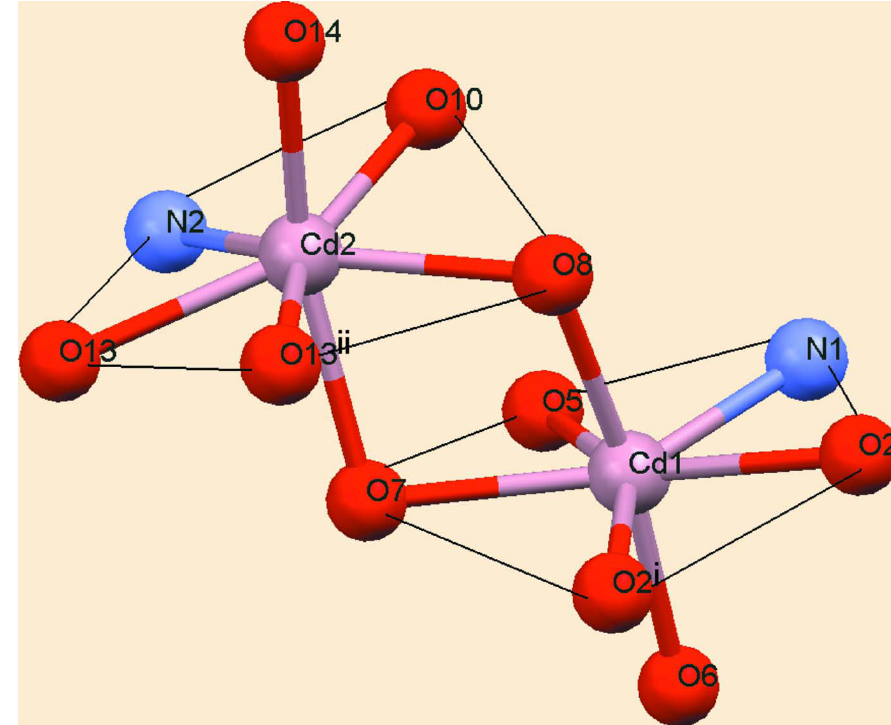
Figure 2 Coordination polyhedron of the title compound [i: (1 - x , 1 - y , 1 - z ) and ii: (1 - x , - y , 1 - z